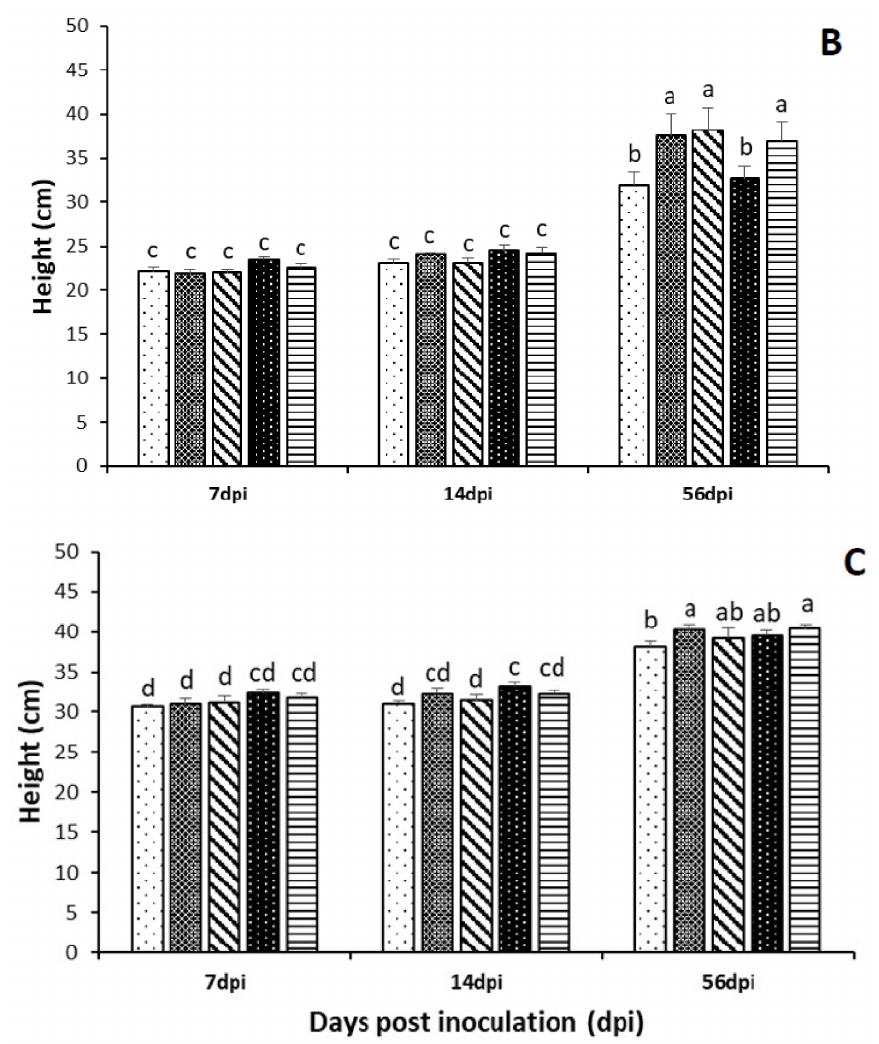
Figure 2. Mean ( ± SE) plant height of citrus seedlings at 7, 14, and 56 days post-inoculation (dpi) with entomopathogenic fungal strains (BB Fafu-12, BB Fafu-13, MA Fafu-1, and BB Fafu-16) or sterile distilled water containing 0.1% Tween 80 (Control). ( A – C ) are showing the height of citrus seedlings treated at 3, 4, and 6 months post-planting, respectively. Bars ( ± SE) with di ff erent letters indicate significant di ff erences among treatments at p < 0.05 (LSD after a two-way